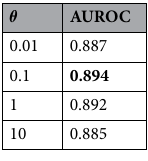
Table 5. Different θ value. Significant values are in